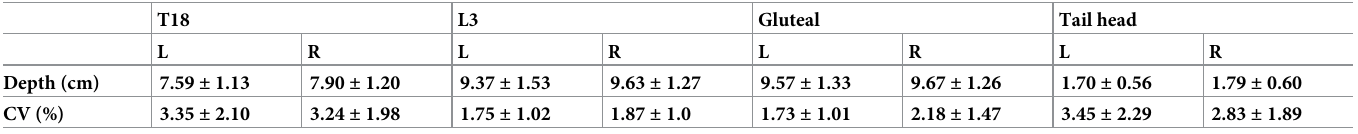
Table 1. Mean (SD) ultrasound depths at the sites; T18 and L3 of the left (L) and right (R) longissimus muscles, the middle gluteal muscle and the tail head (fat).